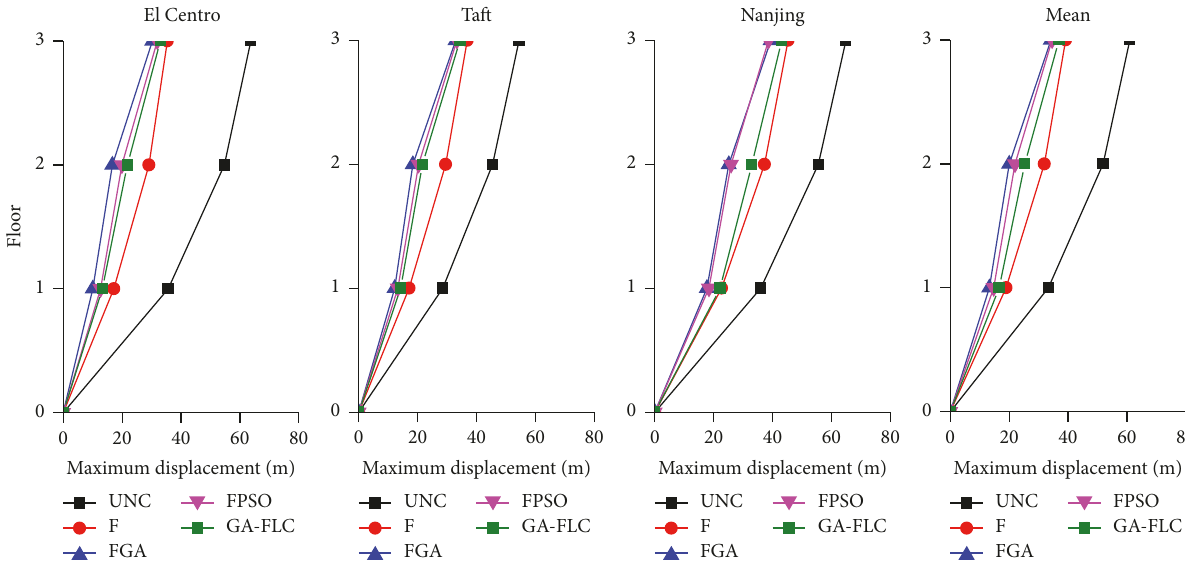
Figure 21: Each layer’s displacement response peak under the action of three seismic